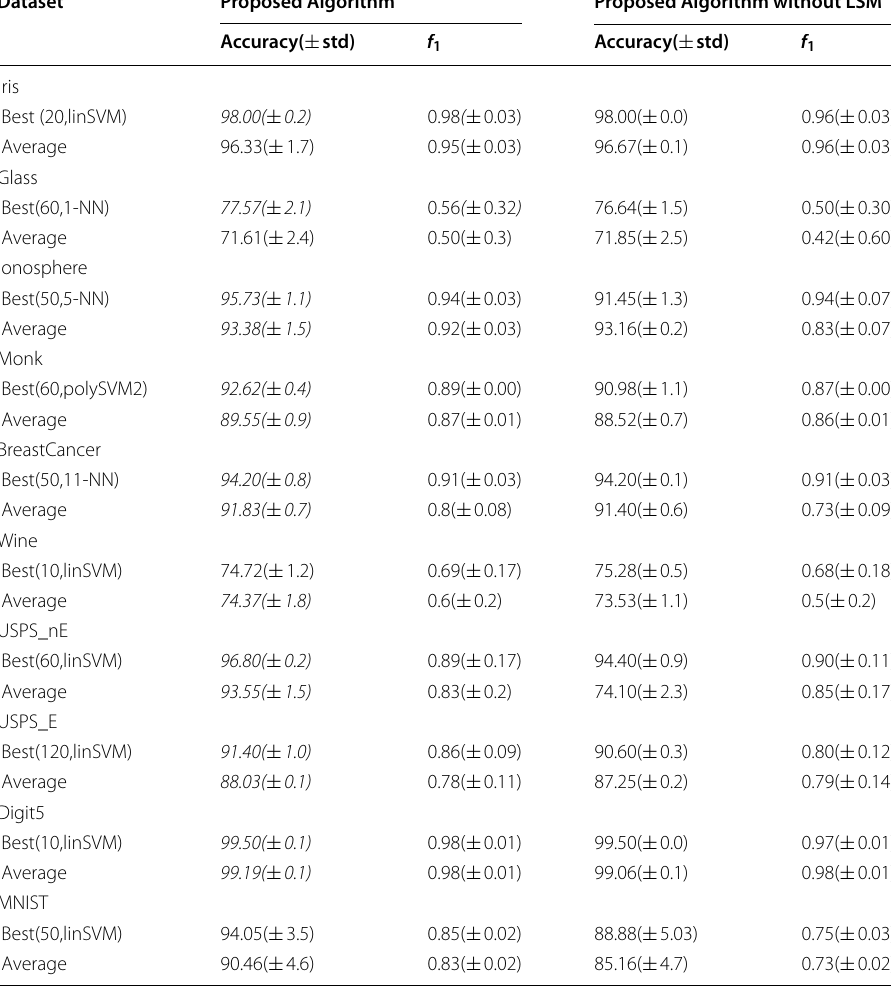
Table 7 Classification accuracy of the proposed method with and without LSM